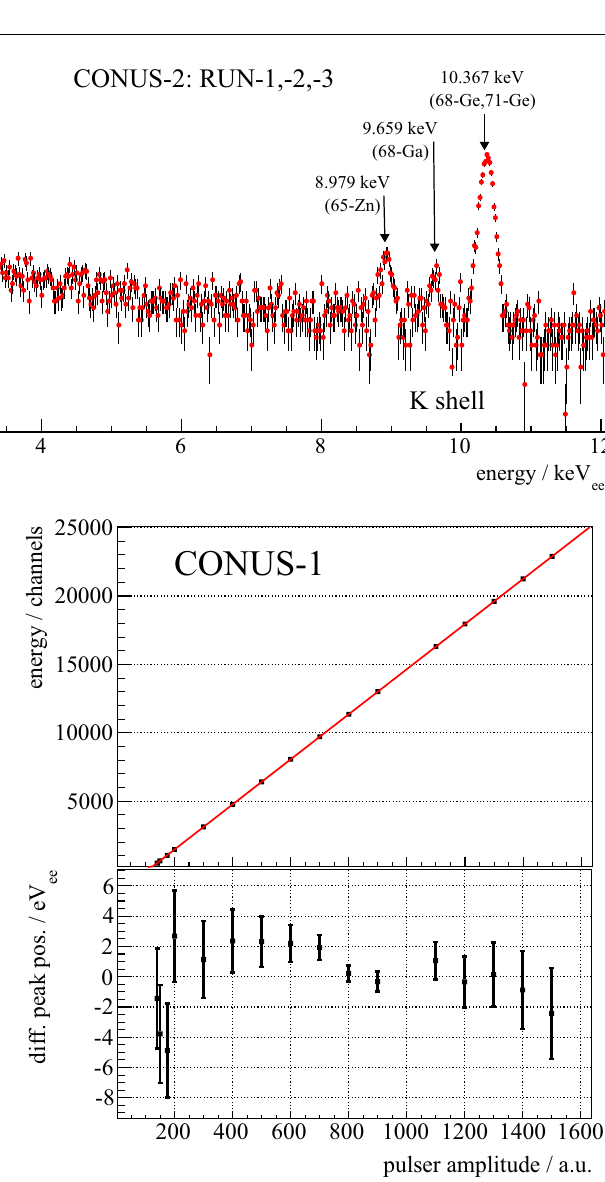
Fig. 11 C1pulserscanperformedduring Run -1usingthe Lynx DAQ. Top canvas: Linearity of the low energy interval [400, 23,000]channel, correspondingto[0.3,11]keV ee .Bottomcanvas:Distanceofpeakposi- tions from linear fit in units of eV ee . The shown error bars include the linear fit